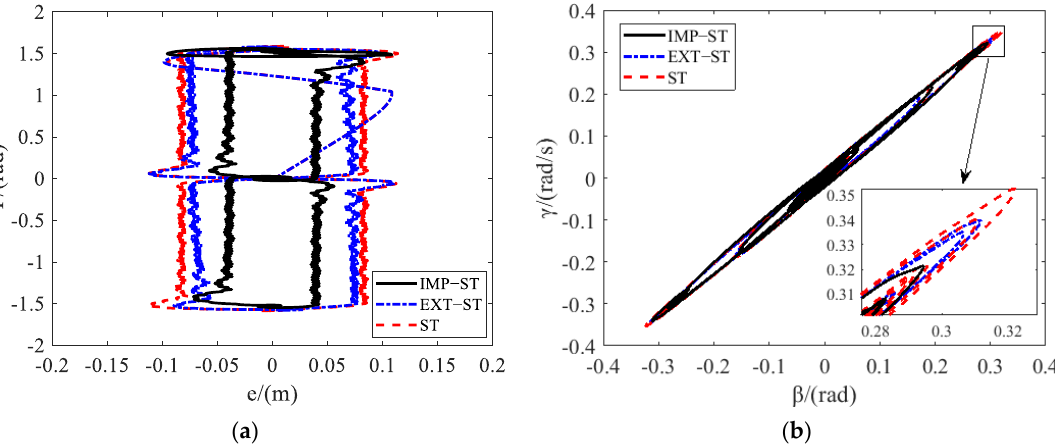
Figure 14. Path tracking stability comparison and analysis. ( a ) e - Ψ phase plane; ( b ) β - γ phase plane.